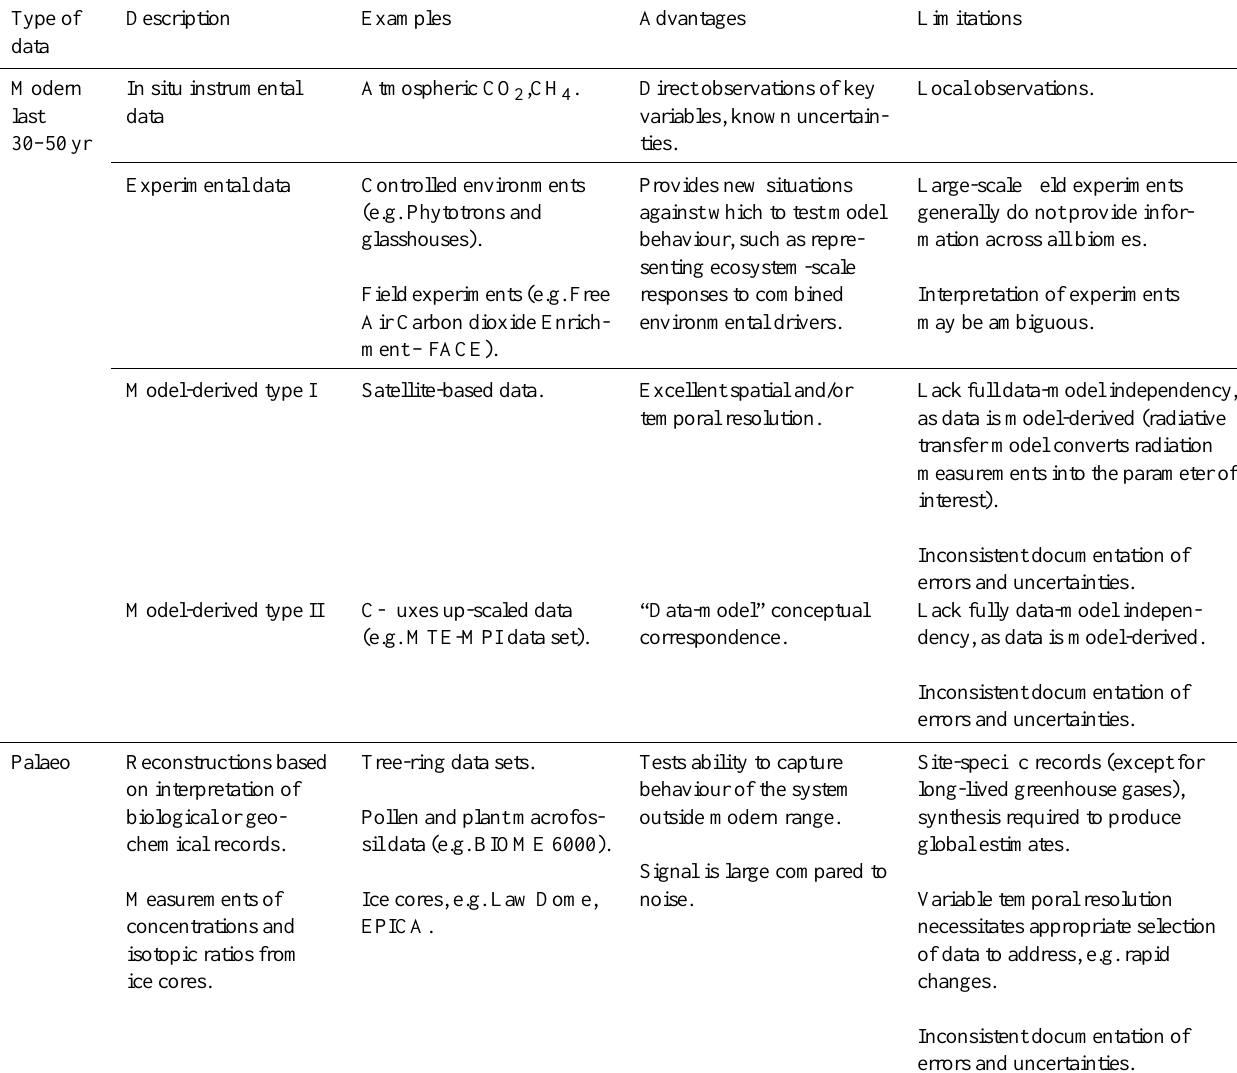
Table 1. Summary of key data types for